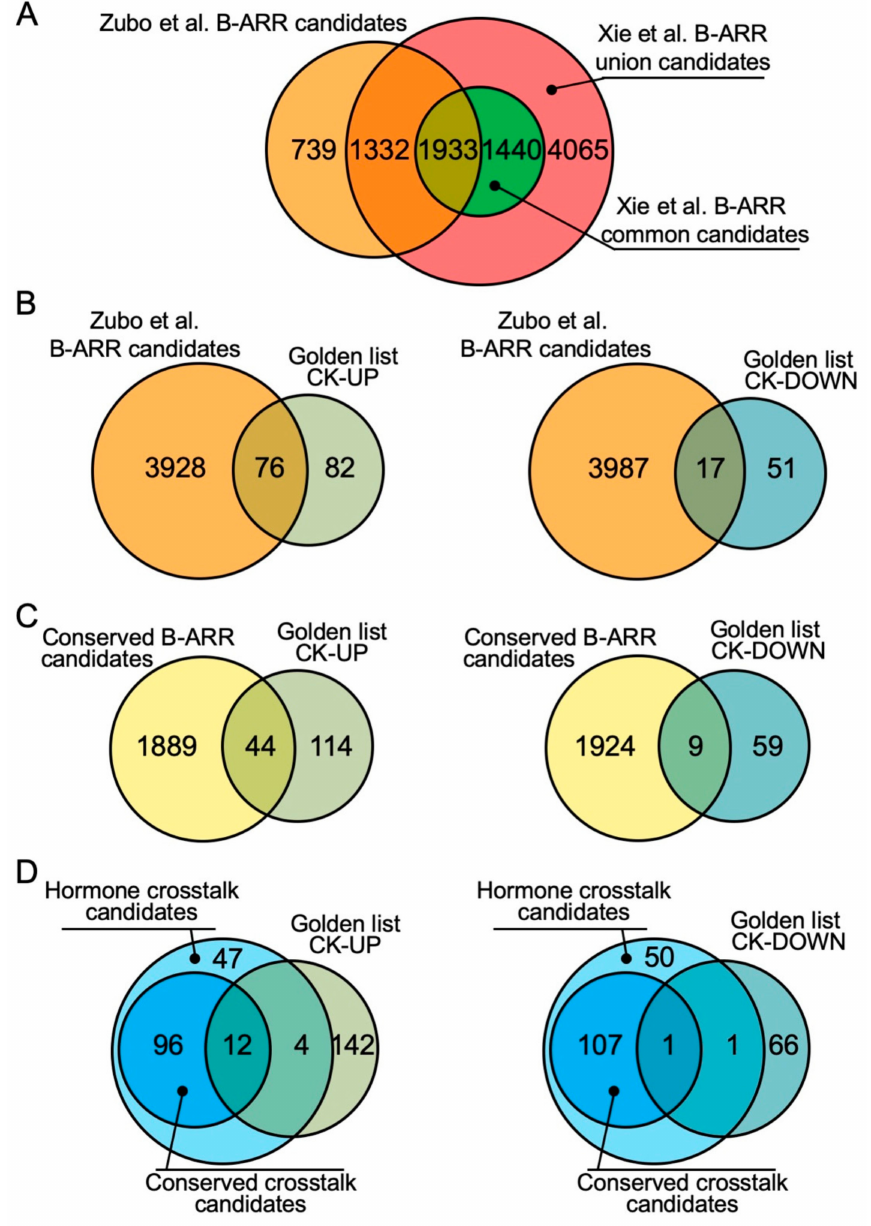
Figure 1. Comparative analysis of the type-B ARABIDOPSIS RESPONSE REGULATOR (ARR) Chromatin Immunoprecipitation-sequencing (ChIP-seq) datasets. ( A ) Venn diagram comparing B-ARR candidate genes from Zubo et al. [24] to Xie et al. [34]. ( B ) Venn diagrams comparing Zubo et al.